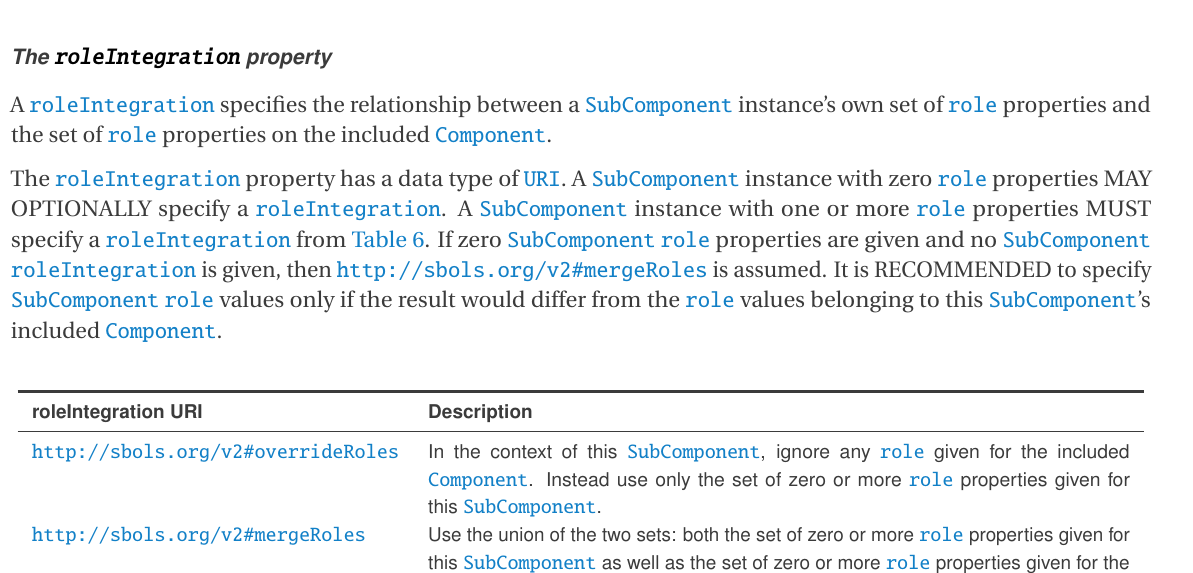
Table 5: REQUIRED URI s for the orientation property